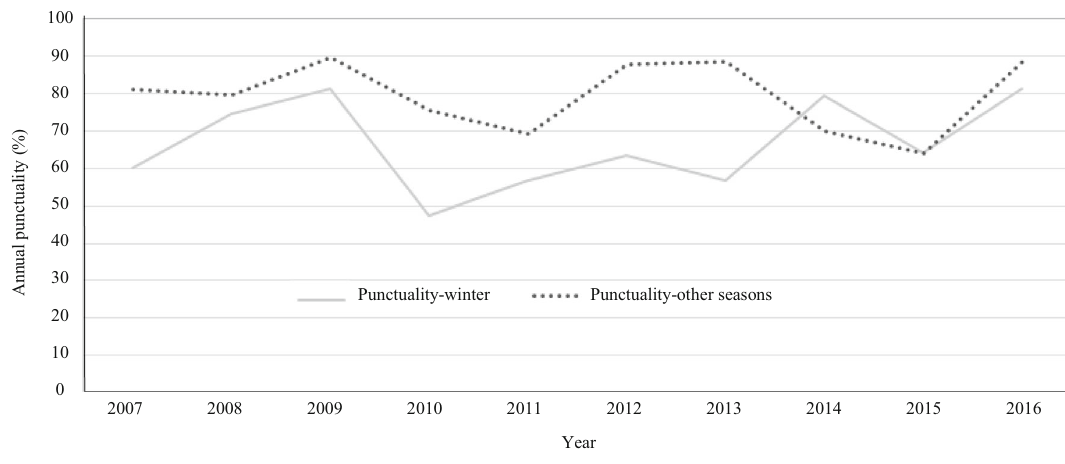
Fig. 4 Annual punctuality in Nordland Line. Data source: